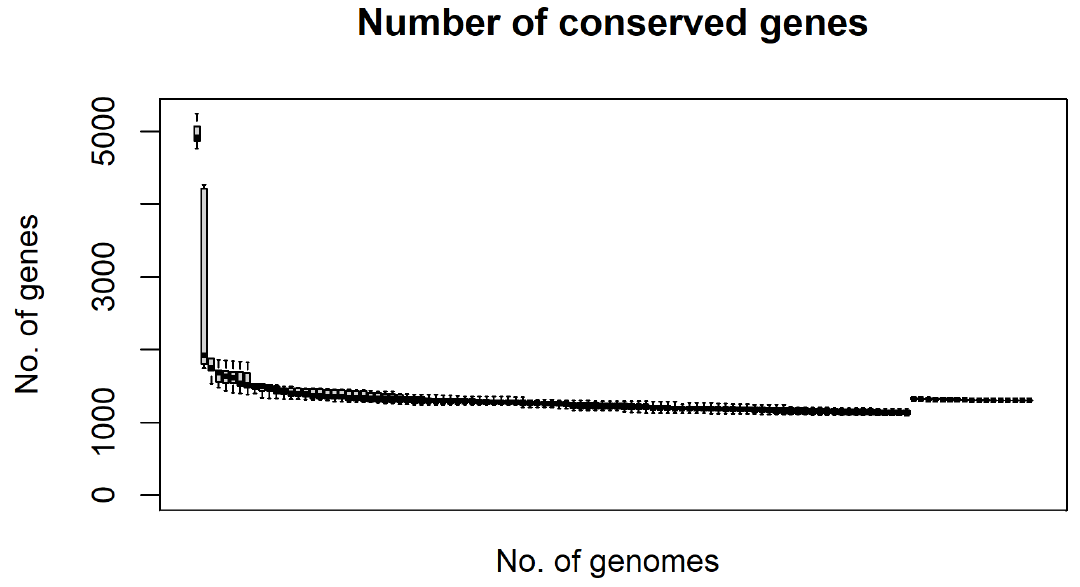
Figure 5. Pangenome development considering conserved genes throughout the 120